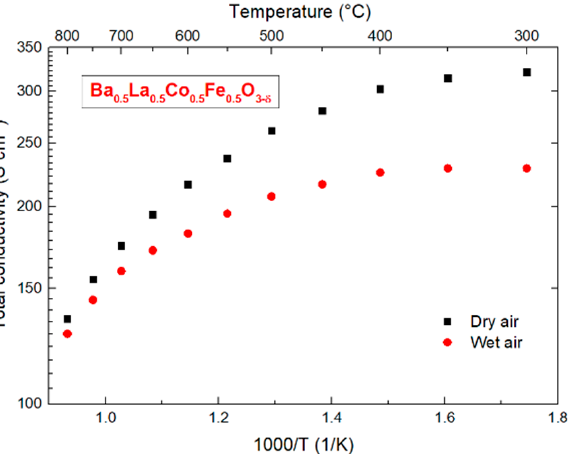
Figure 13. Temperature dependence of total conductivity for Ba 0.5 La 0.5 Co 0.5 Fe 0.5 O 3 − δ recorded in dry and humidified air.